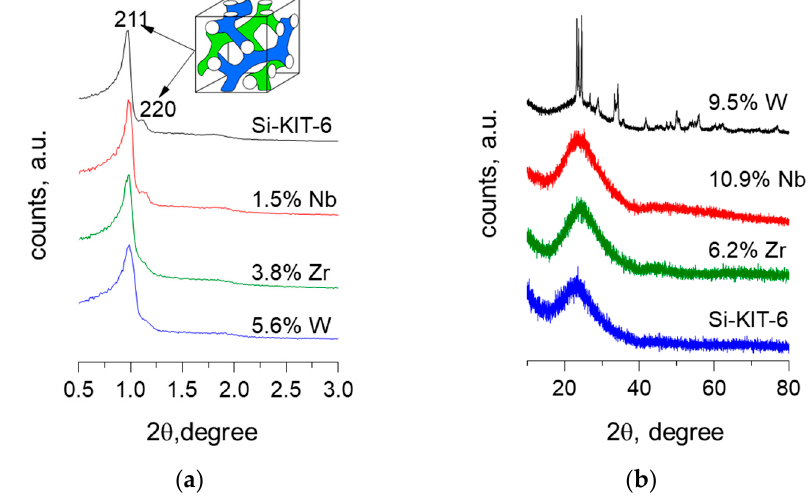
Figure 2. ( a ) Representative SAXS patterns, and ( b ) XRD diffractograms of M-KIT-6, at various metal loadings compared with pristine Si-KIT-6.